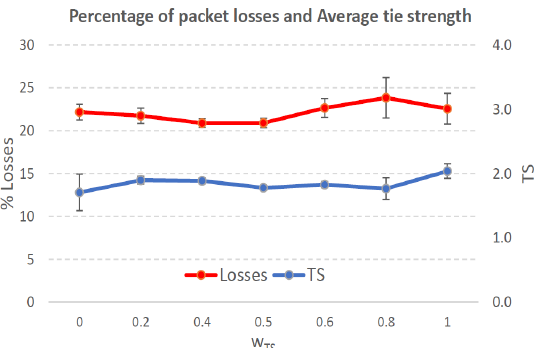
Figure 8. Percentage of packet losses and average tie strength of the forwarding path. Scenario with low social media interaction (TS normal distribution with µ = 2 and σ = 1). Nodes’ density = 100 nodes/km 2 .